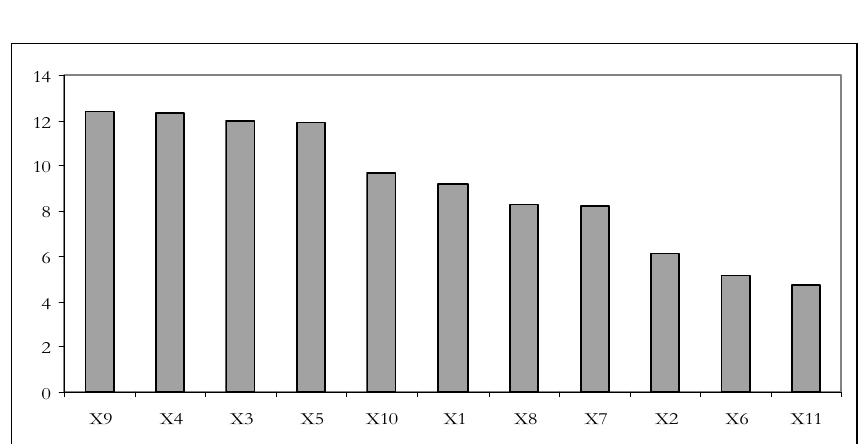
Figure 2 – Average contribution to the multidimensional poverty ratio of the 11 indicators.